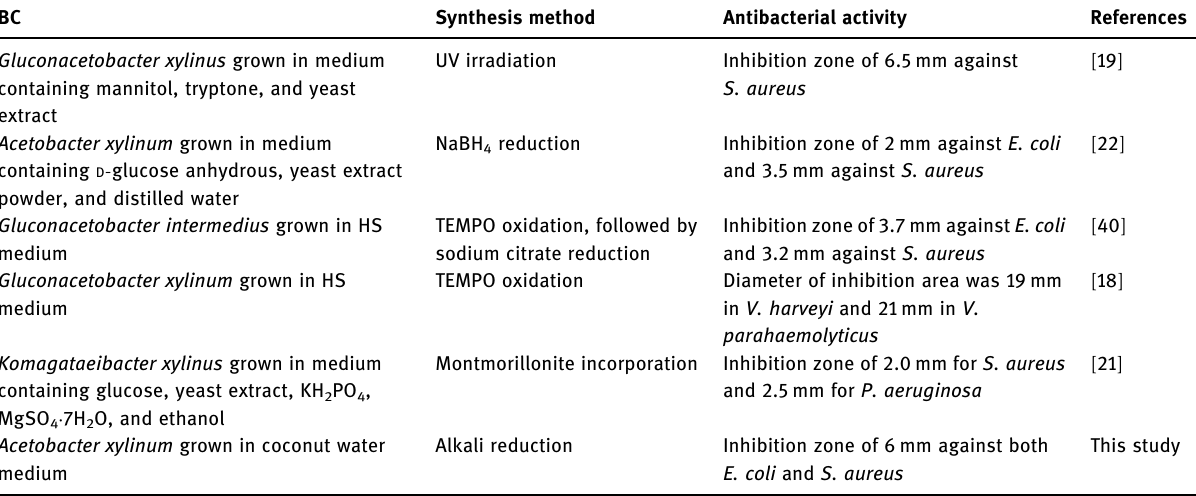
Table 2: Comparison of antibacterial activity of several AgNP/BC composite materials